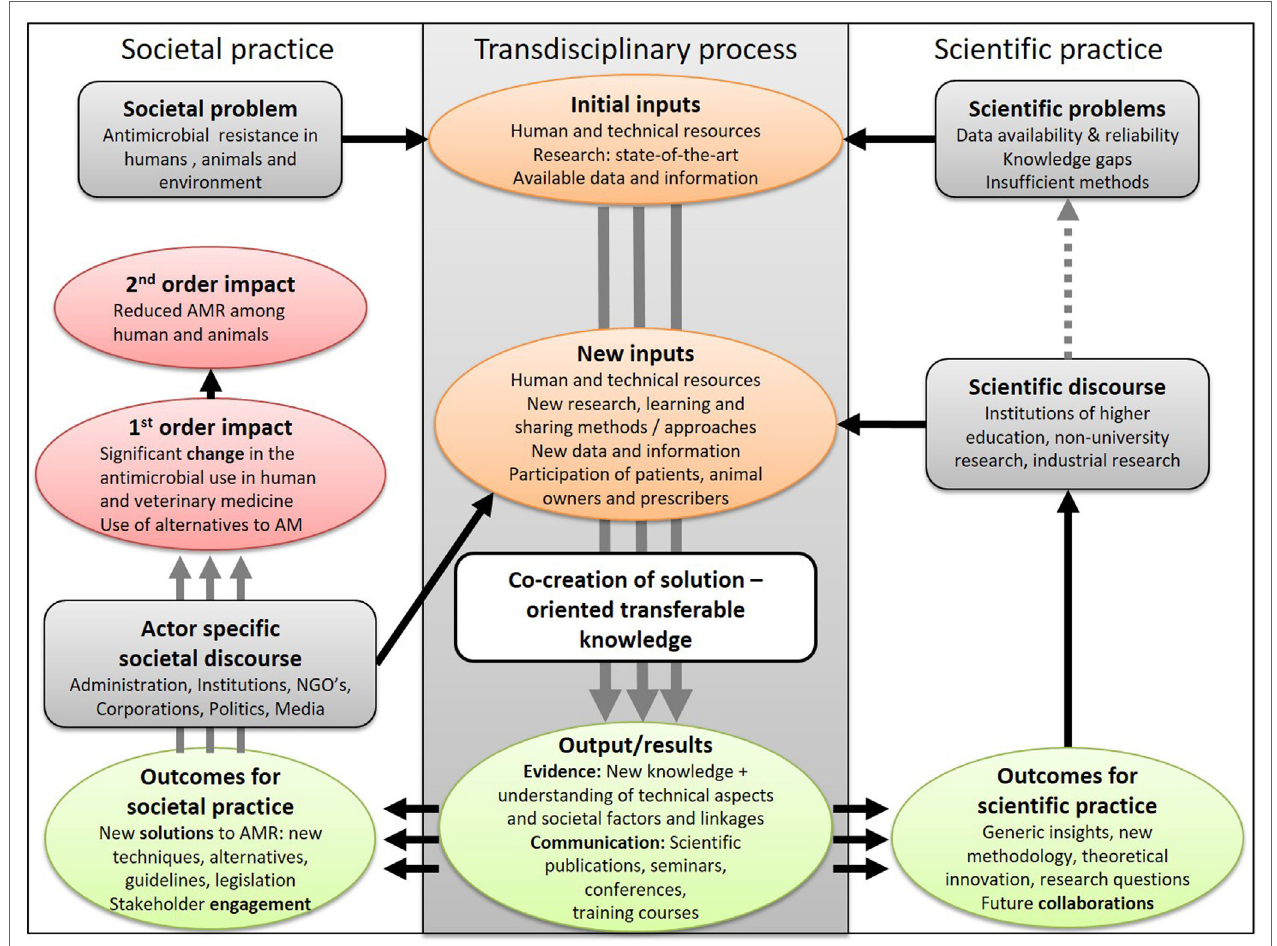
FIgURe 3 | The change pathway for a fictive One Health research initiative aiming to mitigate the development of antimicrobial resistance in a transdisciplinary process. It illustrates the inputs from science and society to co-produce outputs that are taken up by society and the scientific community and disseminated through a specific discourse before resulting in first- and second-order impacts and scientific progress. On the way to impact(s) several iterations with new inputs and outputs of the transdisciplinary process may be